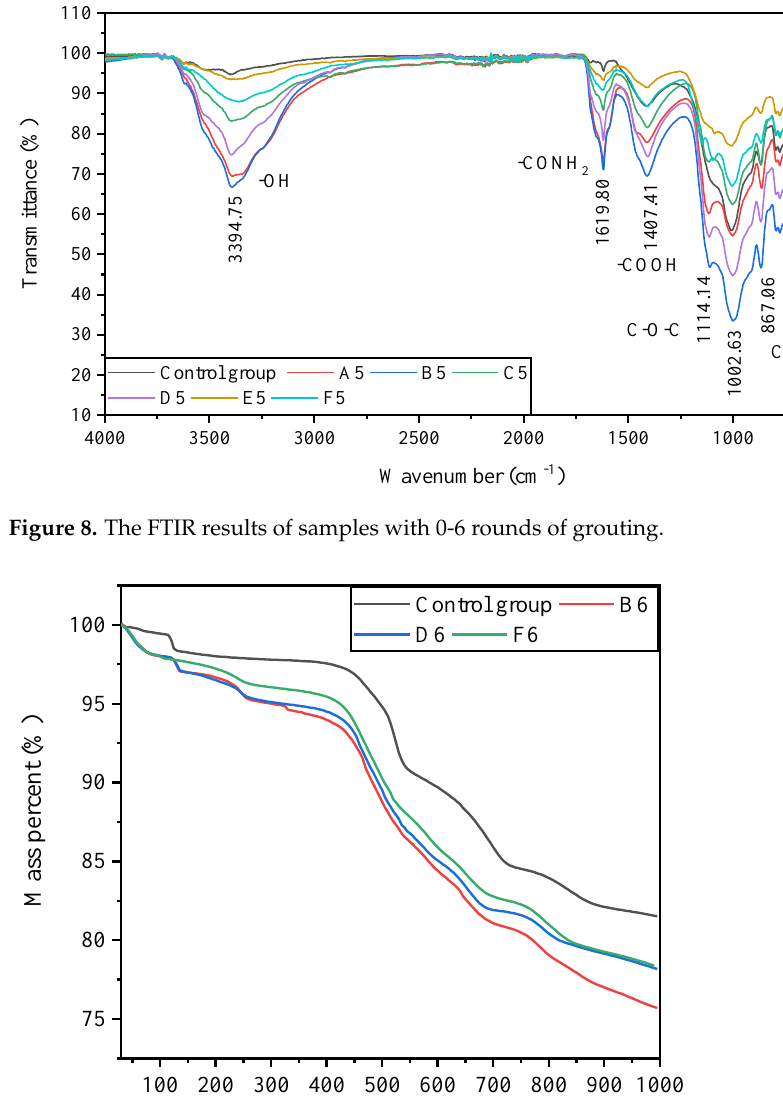
Figure 10. DTG results of classic samples. 3.3.4. SEM Results The SEM results are shown in Figure 11. Figure 11a shows an image of a sample from the blank control group magnified 2000 times. It can be seen from the figure that the un- treated pyrite tailings had many voids and were very loose. In Figure 11b, an image of the B1 sample magnified 5000 times clearly shows columnar minerals and tabular minerals, which were judged to be gypsum and aragonite according to their size. In the image of the C1 sample magnified 5000 times, it can also be seen that there were a large number of